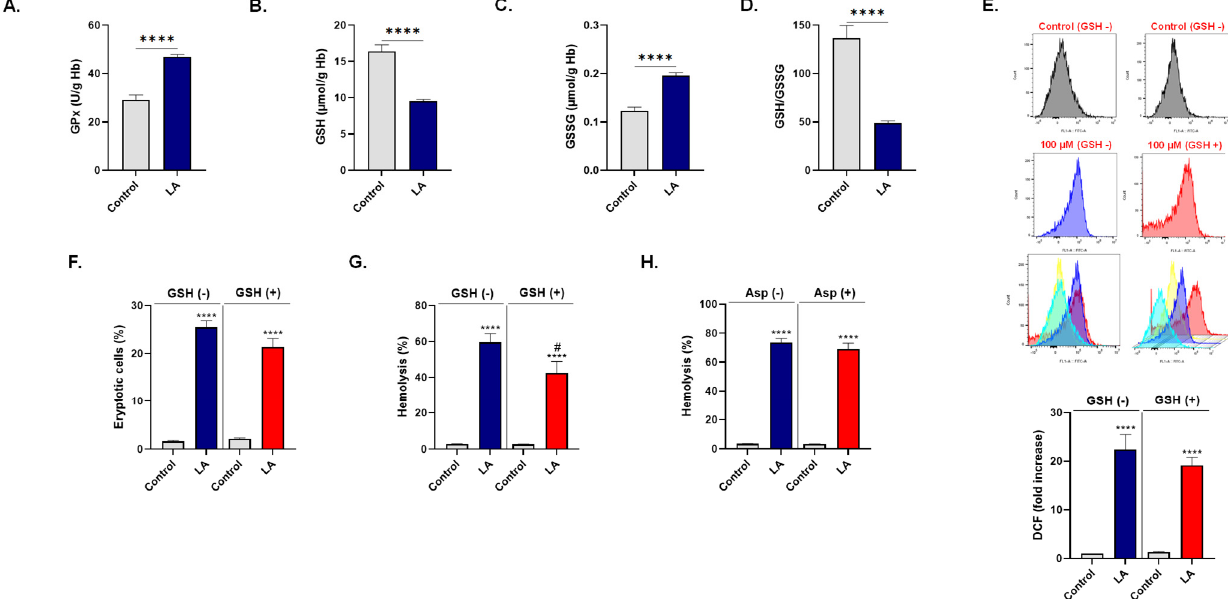
Figure 6. LA disrupts glutathione homeostasis. ( A ) GPx activity in control and experimental (100 µ M of LA) cells. ( B ) Intracellular GSH content. ( C ) Intracellular GSSG content. ( D ) GSH/GSSG ratio. ( E ) Representative histograms and arithmetic means of fold increase in MFI of DCF fluorescence with or without 100 µ M of LA in the presence or absence of 20 µ M of GSH. ( F ) Eryptosis and ( G ) hemolysis of cells treated with 100 µ M of LA in presence or absence of 20 µ M of GSH. ( H ) Hemolysis with or without 100 µ M of LA in the presence or absence of 50 µ M of Asp. **** ( p < 0.0001) indicates significantly different values from control conditions whereas # ( p < 0.05) indicates statistical significance compared to LA-treated cells.